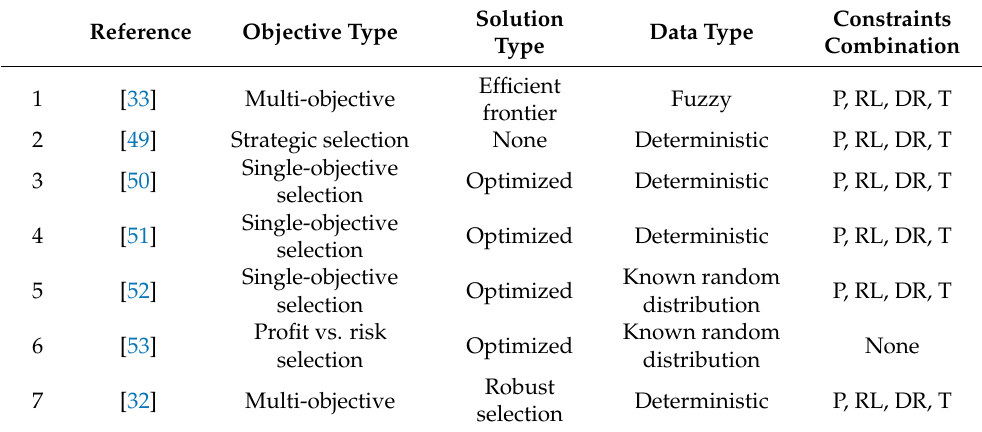
Table 1. Examples of the suggested